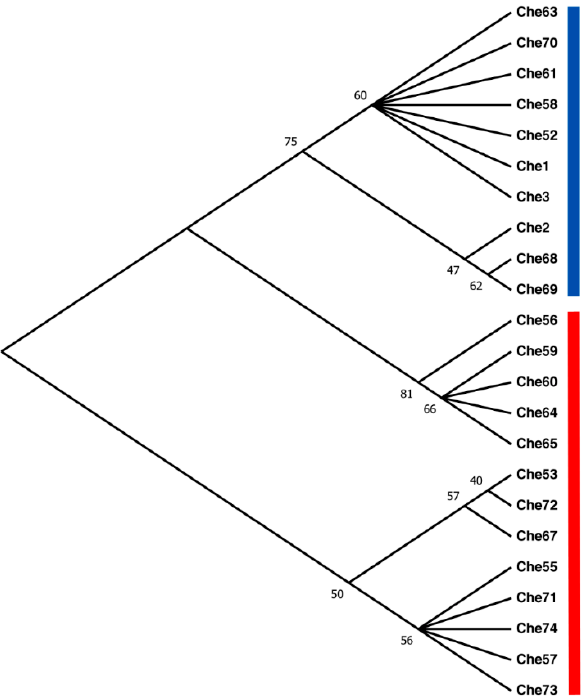
Figure 3. Evolutionary relationships of taxa based on matK sequences inferred with a Neighbor- Joining method using the p -distance. Bootstrap values are shown, and branches with values below 20 are collapsed. A total of 773 positions were present in the final dataset.